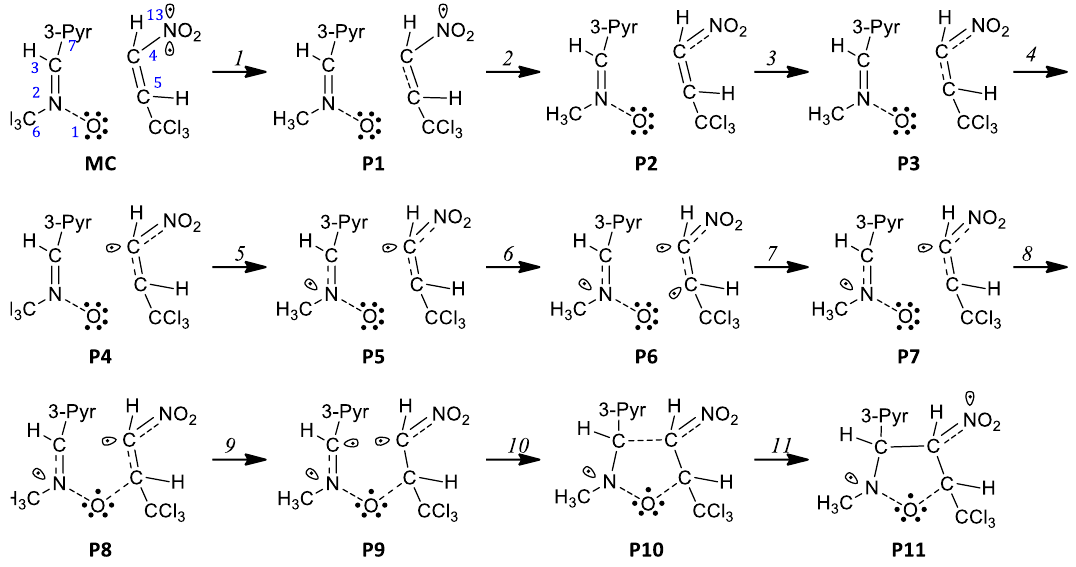
Scheme 3. Simplified representation of the molecular mechanism of the 32CA reaction involving C-3-pyridino-N-methyl nitrone 1 with 3,3,3-trichloro-1-nitroprop-2-ene 2b by Lewis-like structures derived from the topological analysis of the ELF along the reaction path.